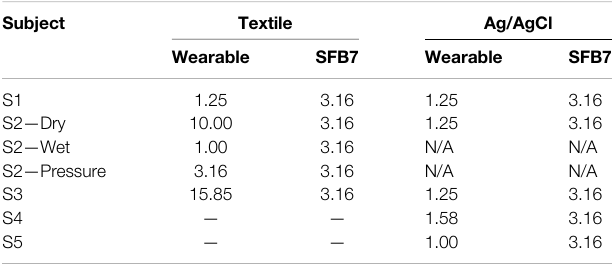
TABLE 3 | Percent error of the Cole parameters extracted from bioimpedance measurementsfromboth measurementsystemsforthetest RRCs compared with the actual values of the RRCs.